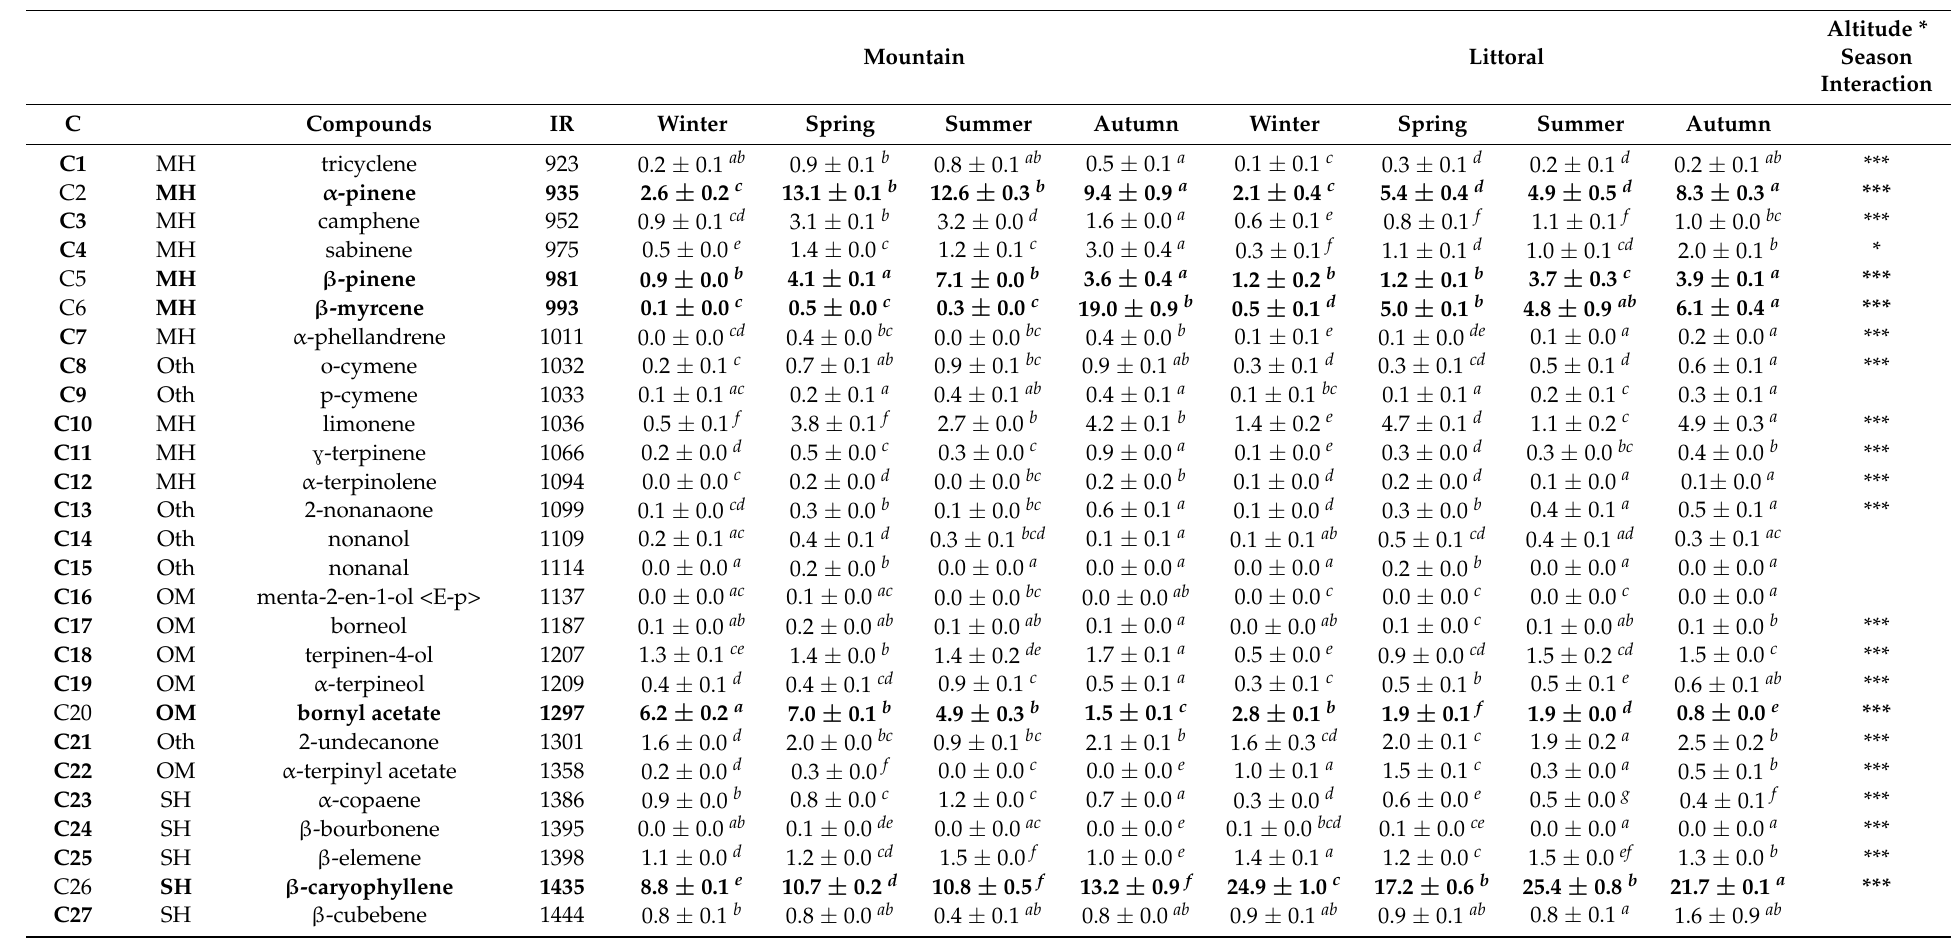
Table 1. Compounds detected in the essential oils of Pistacia lentiscus leaves collected at two altitude sites and in four consecutive seasons. The levels of each compound are expressed as the chromatographic relative peak surface measured as the total ion current (area % TIC). The extraction yield for each EO was similar: 0.125 ± 0.005 g/100 g of dry